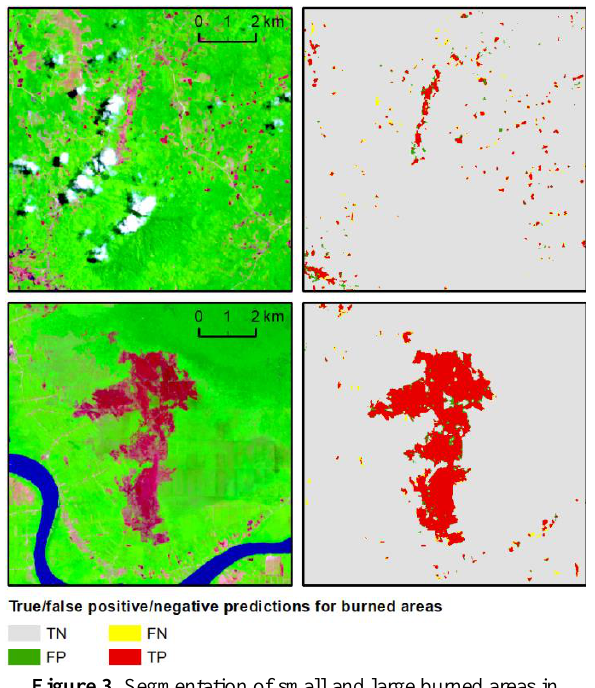
Figure 3 . Segmentation of small and large burned areas in Indonesia (RGB composition: B12/B8/B3).